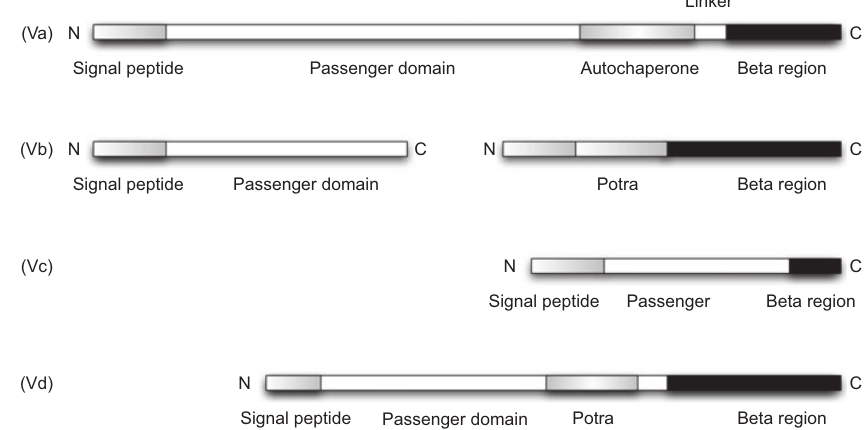
Figure 2 The structure of autotransporter